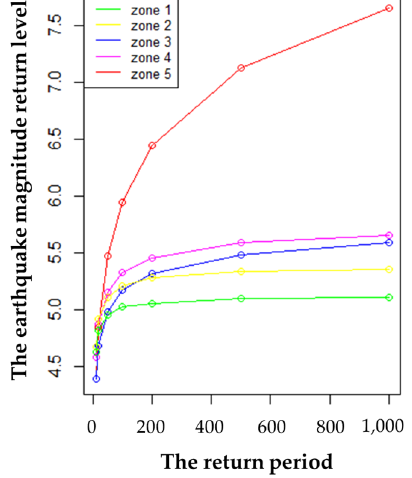
Figure 13. The earthquake magnitude return level in Cluster Type I